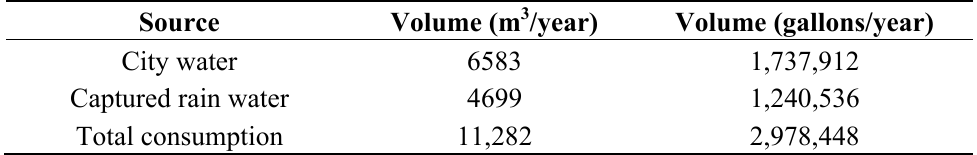
Table 4. Annual whole building water consumption in 2011 by source.